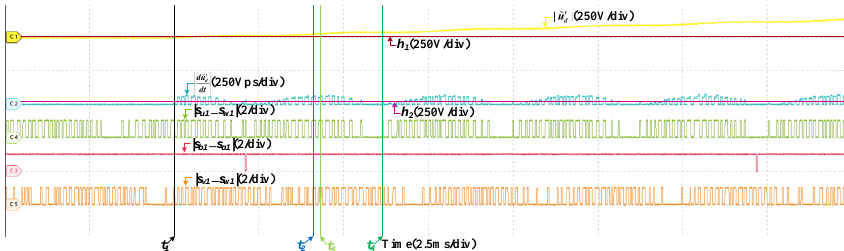
Figure 16. HIL results when the scaling fault occurs in S Cu at 200 km/h.